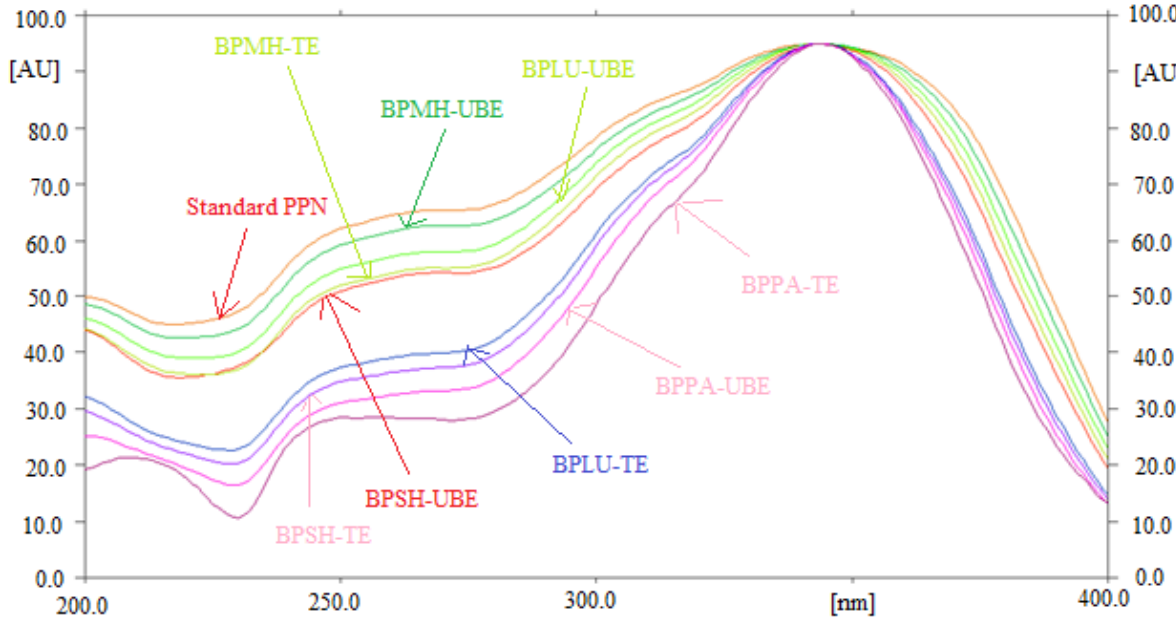
Figure 3. Overlaid ultra-violet (UV) absorption spectra of standard PPN and PPN in traditional and ultrasound-assisted extracts of different commercial samples of black pepper.